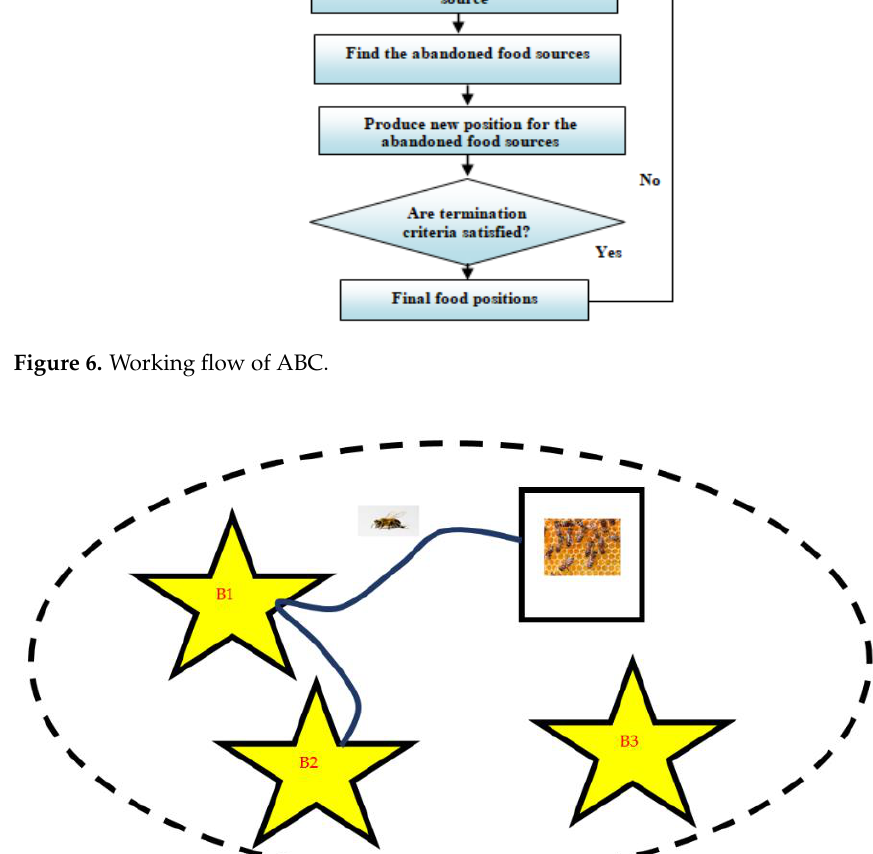
Figure 7. Scouting mechanism of ABC.